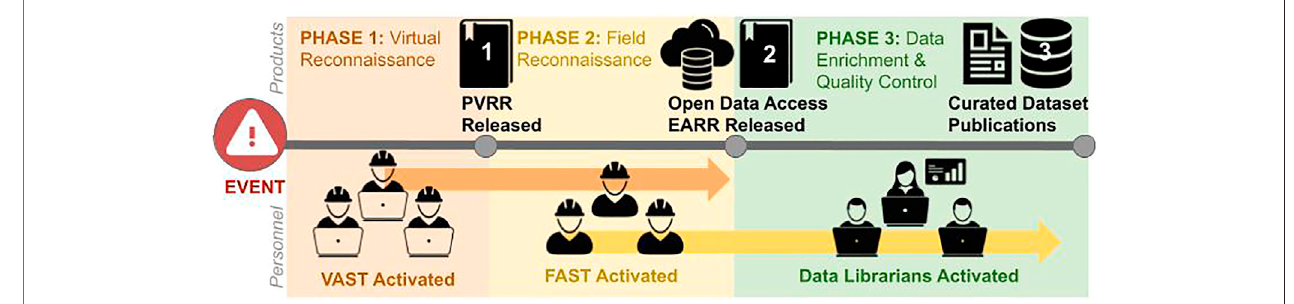
FIGURE 2 | Evolution of products and personnel across the three phases of a typical StEER fi eld